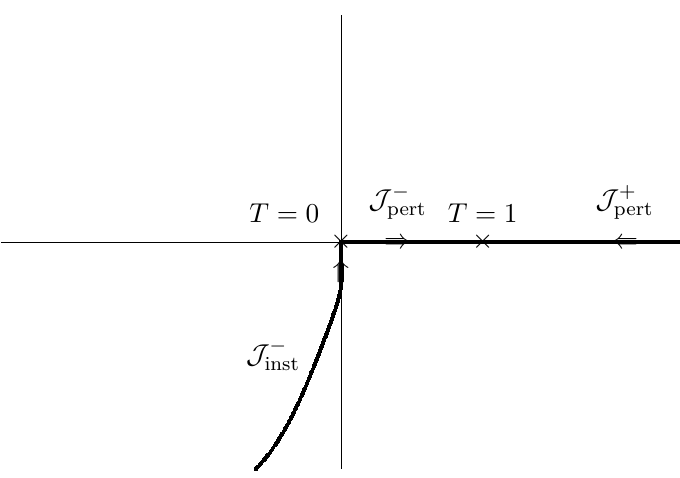
Figure 17 . The steepest descent contours for the action (8.6) in the complex T